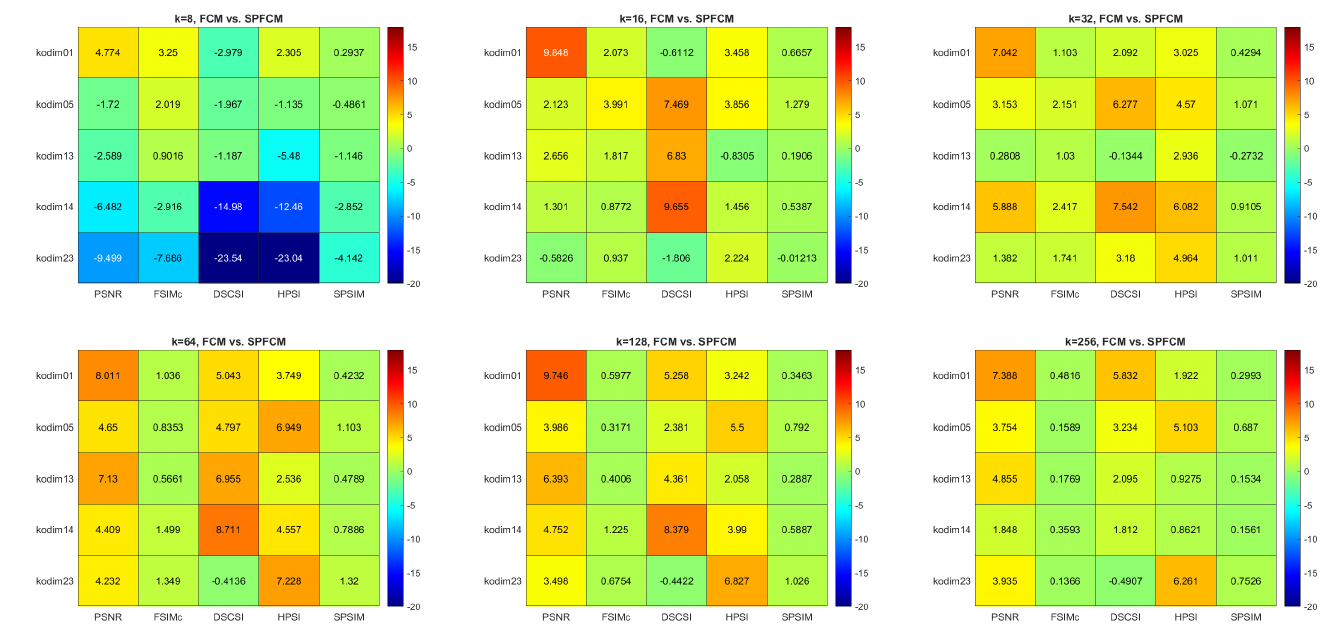
Figure 6. Multi − index quality assessment of quantized images: FCM versus SPFCM.